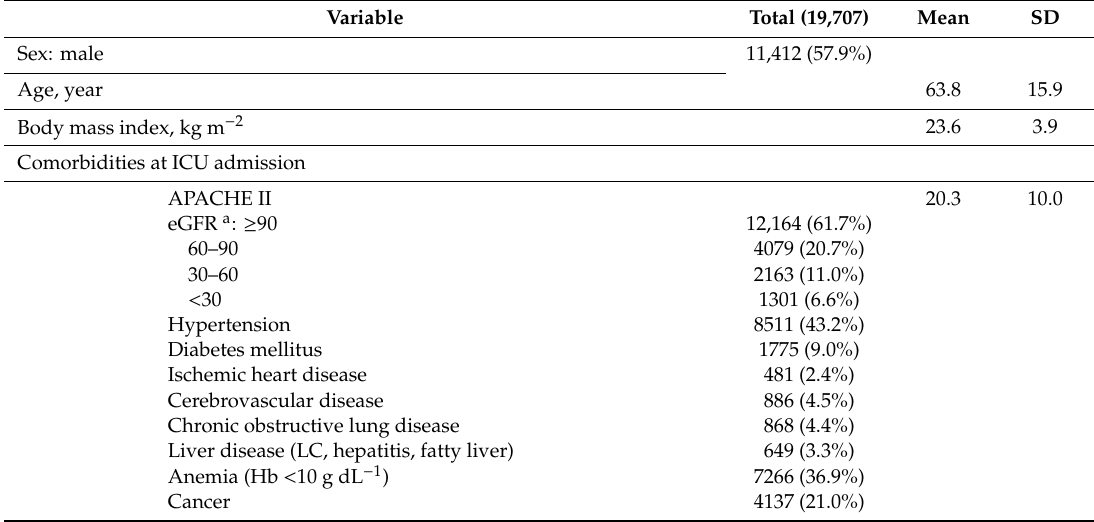
Figure 1. Flow chart of patient selection. Table 1. Baseline characteristics of adult patients admitted to the ICU between 2012 and 2017.